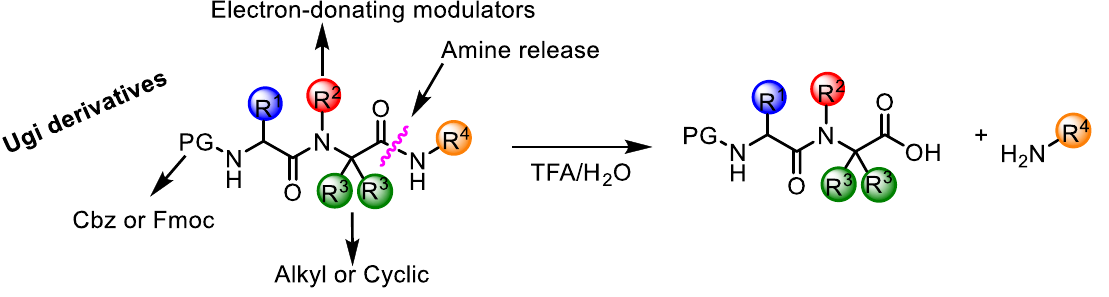
Figure 1. Patterns of N -alkylated α,α-dialkylglycine and acidolysis of the C-terminal amide bond of α,α-dialkylglycine derivatives and their dependence on R1 and R2.